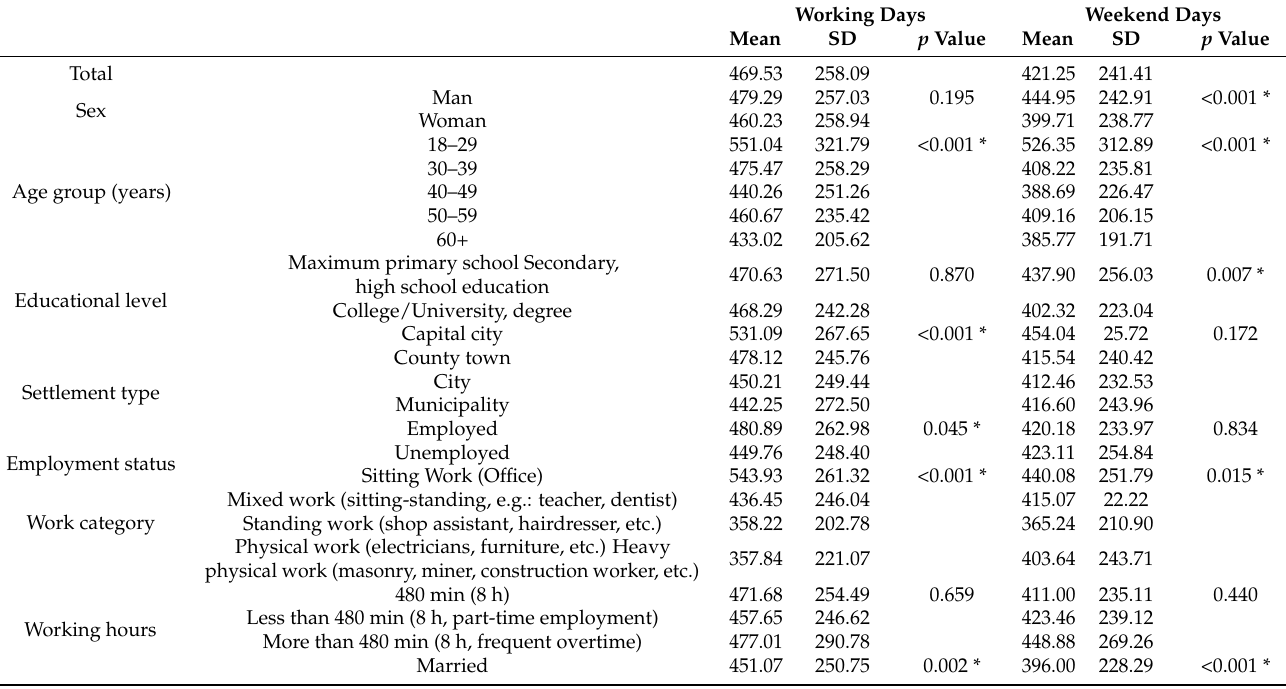
Table 3. Mean sitting time (SBQ) in minutes with respect to the different categories of the sample in weekdays and weekend